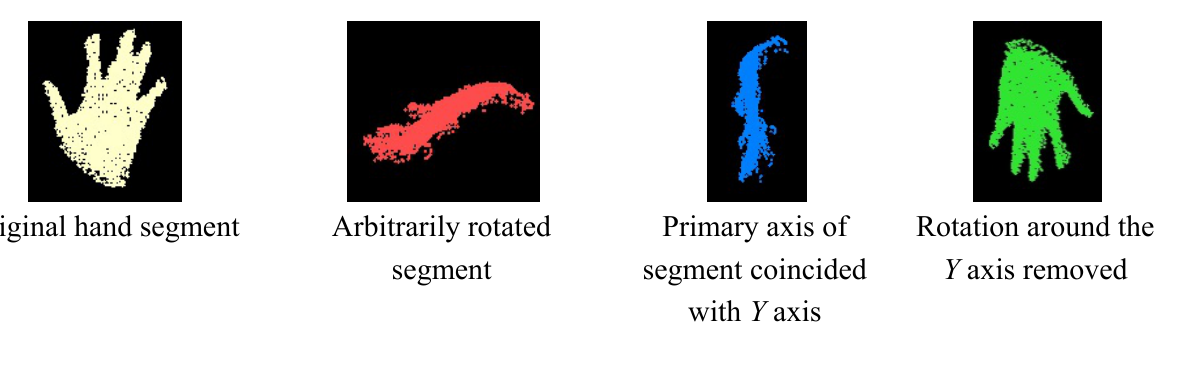
Figure 12. Example of an incorrect rotation removal of a hand